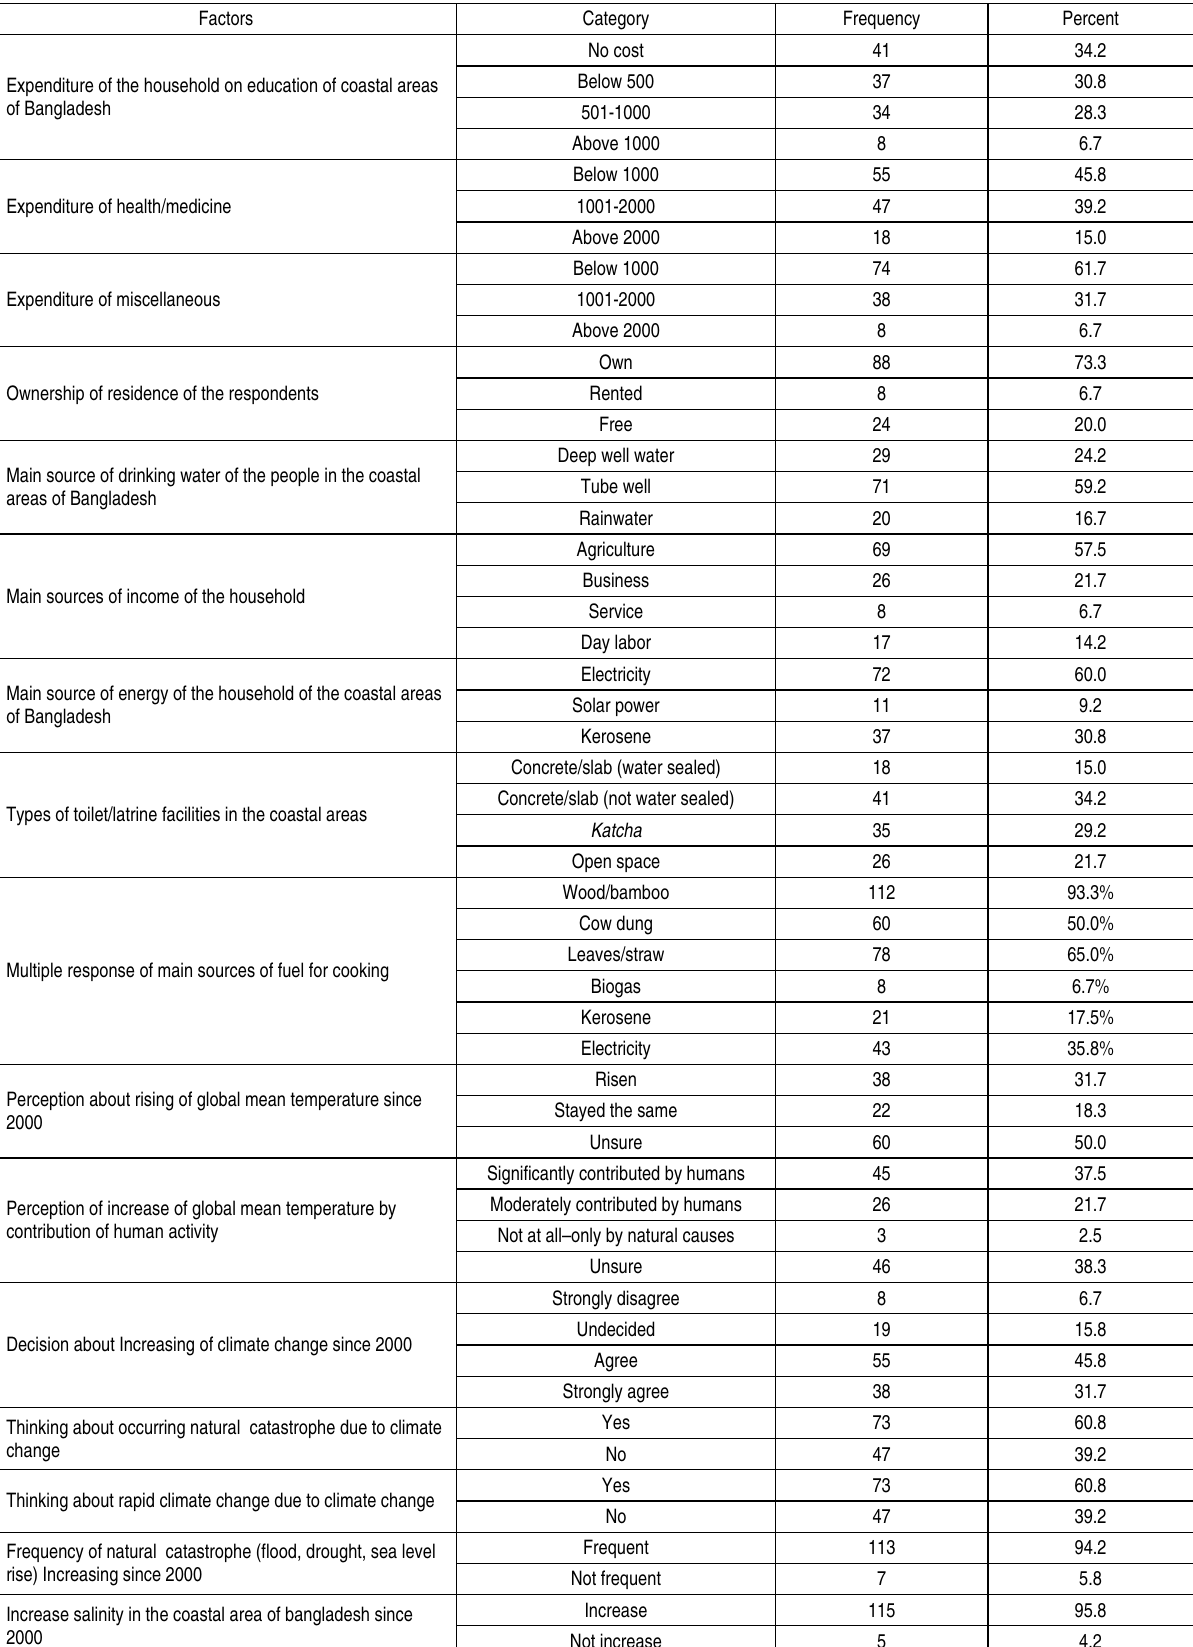
Table 1 (cont.). Demographic information with frequency level and